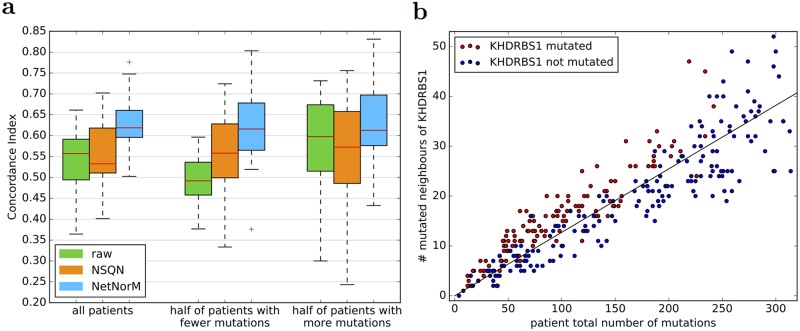
Analysis of predictive genes.(a) Comparison of survival prediction performances according to patients’ mutational burden for LUAD. Three different representations of the mutations are used to perform survival prediction using a ranking SVM: raw (the raw binary mutation data), NSQN (network smoothing with quantile normalisation) and NetNorM. Performances for half of the patients with fewer (resp. more) mutations are derived from the predictions made using the whole dataset. (b) Scatter plot of the total number of mutations in a patient of the LUAD cohort (x-axis) against the number of mutated neighbours of KHDRBS1 in a patient (y-axis). Only patients with less than kmed = 295 mutations are shown, where kmed is the median value of k learned across cross-validation folds. Red (resp. blue) indicate patients mutated (resp. non mutated) in KHDRBS1 after processing with NetNorM using k = kmed. The black line was fit by linear regression and by definition indicates the expected number of mutated neighbours of KHDRBS1 given the mutational burden of a patient.